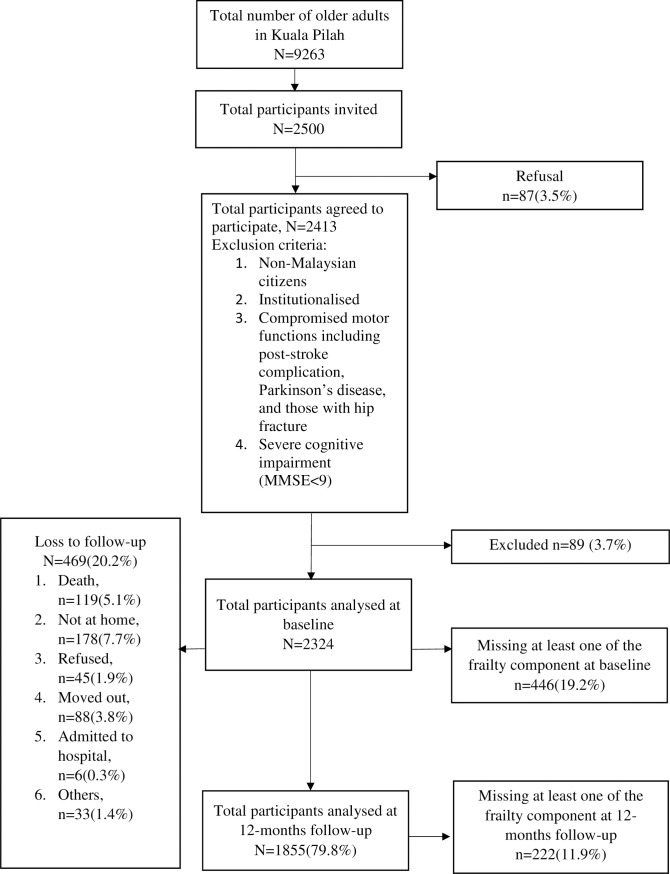
Study flow chart.